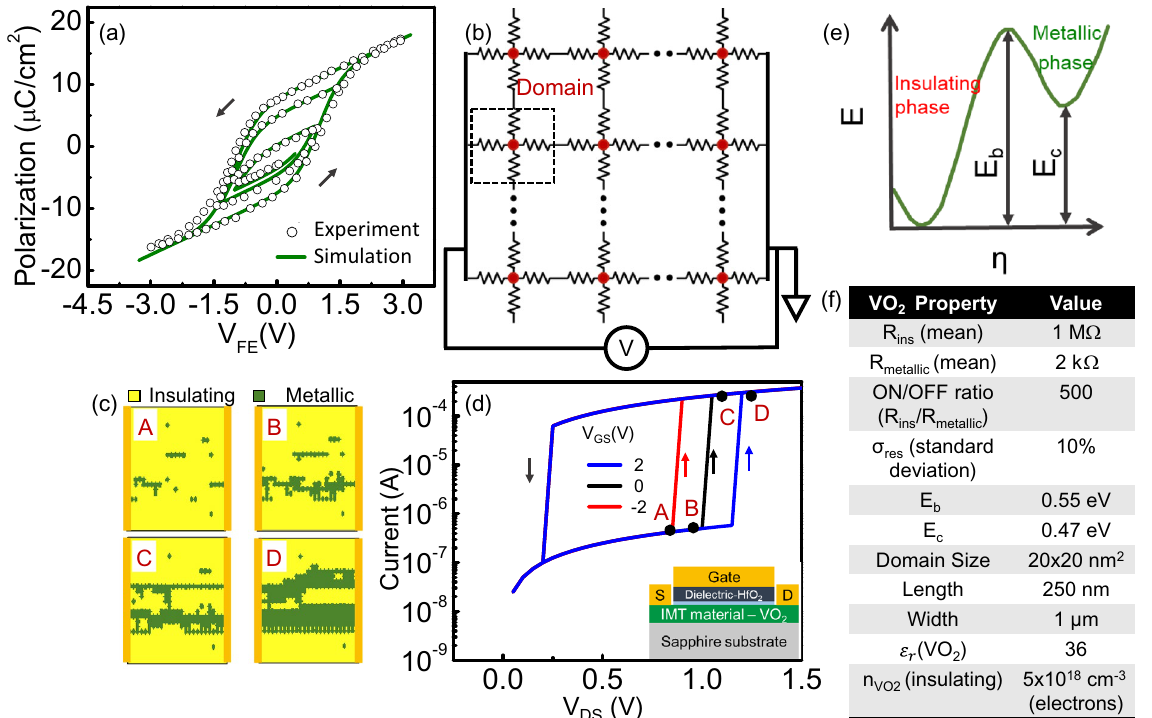
Figure 1. Modeling electrical response of the ferroelectric and VO 2 . ( a ) Polarization versus voltage characteristics of the ferroelectric HfO 2 simulated using the Preisach’s model, and calibrated to the experimental data reported by Mueller et al. 12 ( b ) Two-dimensional resistive network used to model the filamentary switching behavior across the IMT in VO 2 . ( c ) Evolution of the insulating and metallic phases across the electrically driven IMT in VO 2 clearly showing the filamentary switching; the phases are indicated on the black IV curve in next panel. ( d ) Modulation of the threshold voltage for the IMT as a function of the applied electric field. Schematic of the device considered is also shown (inset) ( e ) Phase diagram of VO 2 ( f ) Parameters used for simulation of VO 2